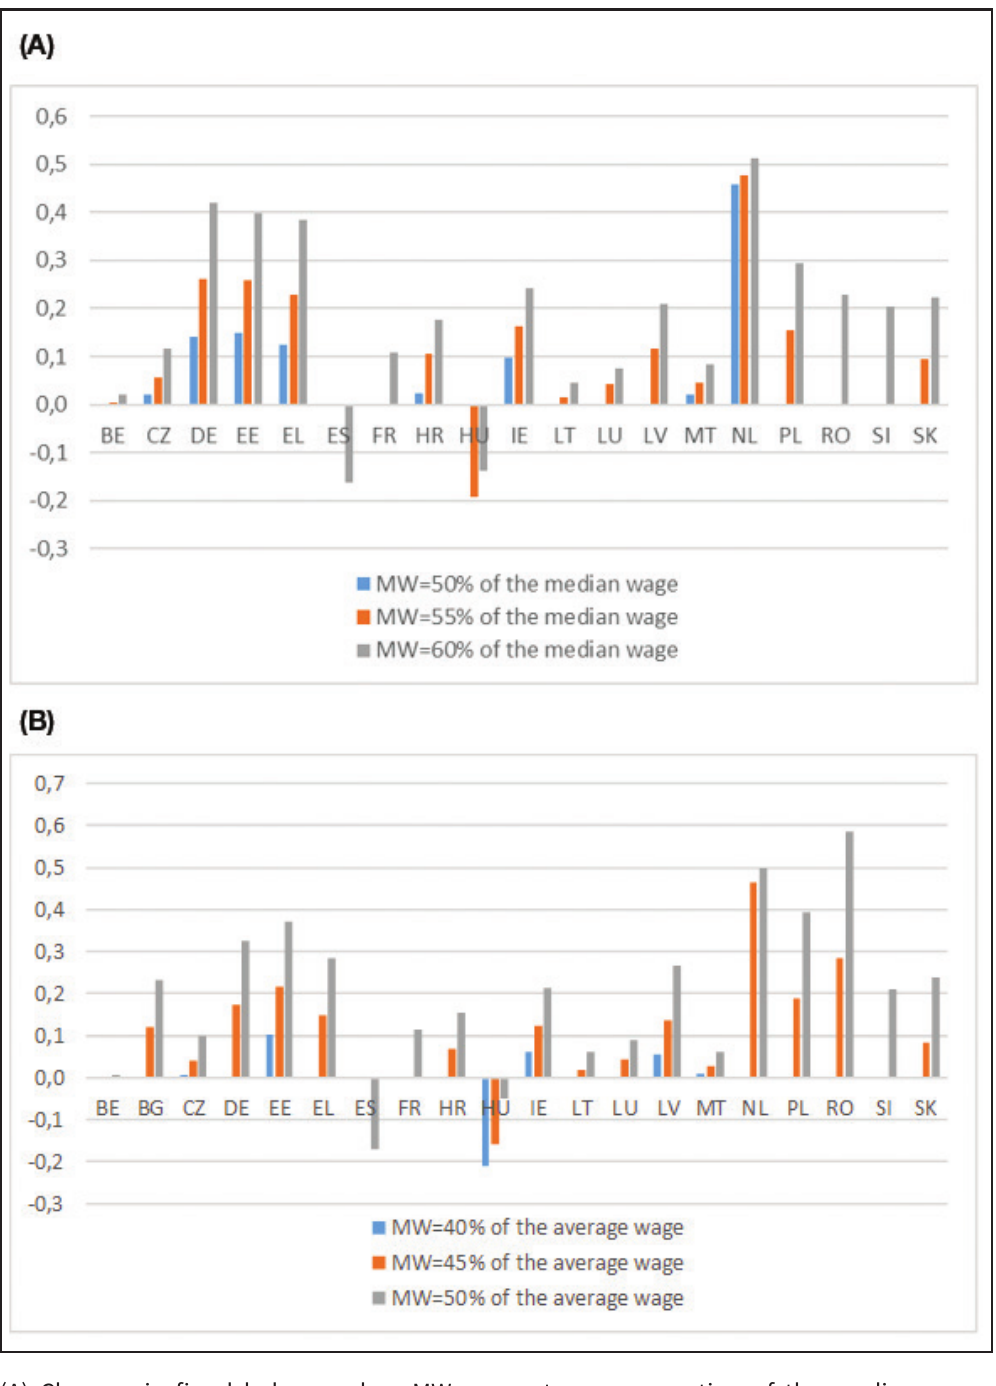
Figure A10 Impact on public budgets (change in fiscal balance as a percentage of